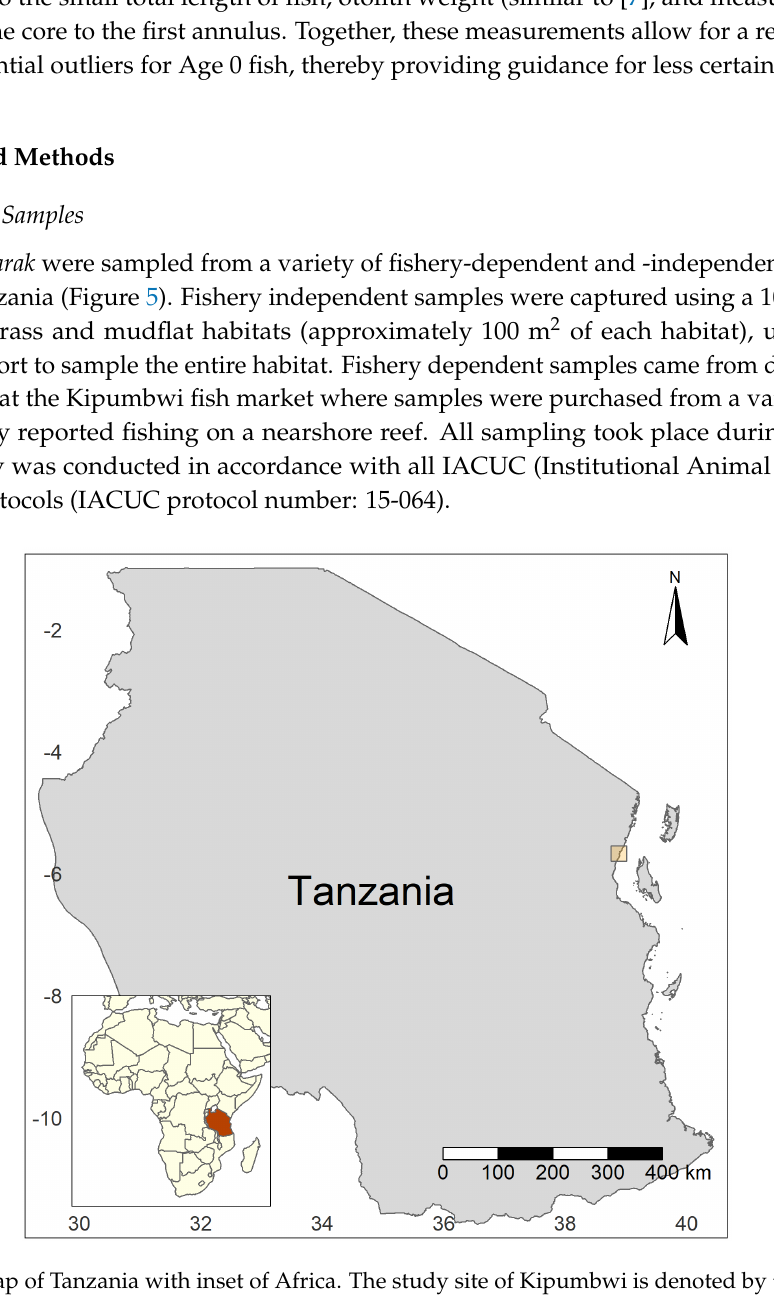
Figure 5. Map of Tanzania with inset of Africa. The study site of Kipumbwi is denoted by the box on the northern